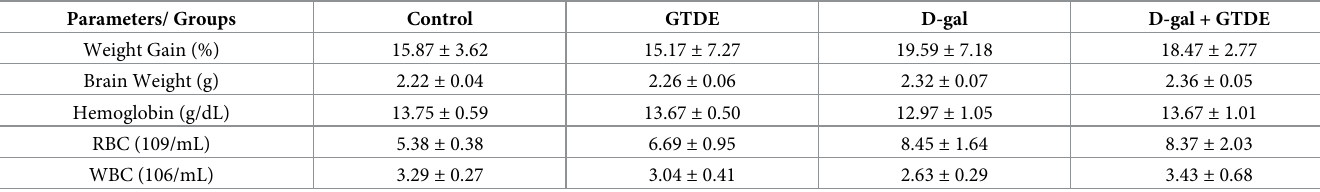
Table 1. Changes in physiological parameters of Long-Evans rats after oral administration of G . tsugae . Parameters/